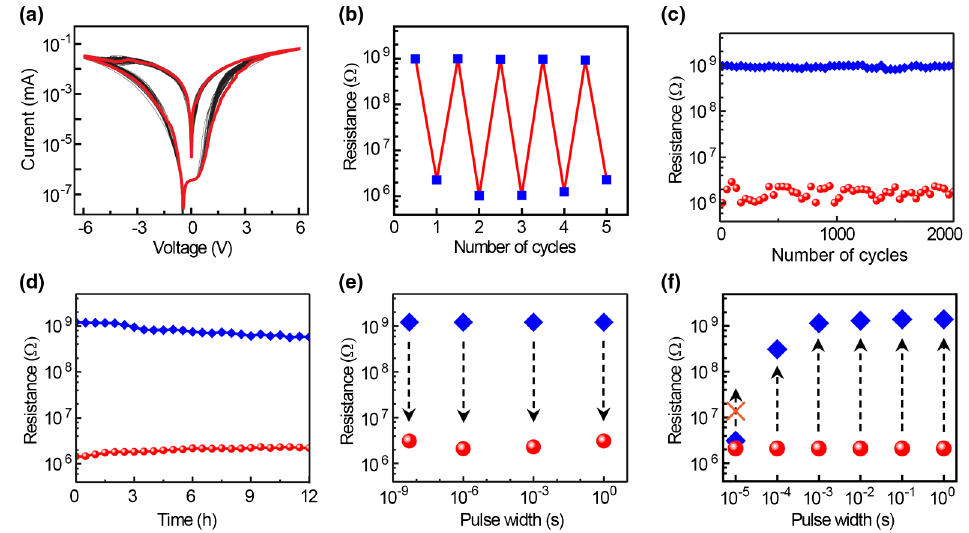
FIG. 10. Nonvolatile resistive switching of the LAO/STO memristors with LAO grown at a relatively high oxygen pressure of 10 (cid:2) 3 mbar . (a) After the initial forming sweep, bipolar resistance switching is very stable during the 100 successive voltage sweeps. The red curve represents the 100th cycle. (b) The HRS and LRS can be reversibly and reproducibly obtained by applying voltage pulses of (cid:5) 6 V . The readout voltage is 0.2 V. (c) Good endurance and no performance degradation are observed after 2000 cycles of write and erase operations. (d) Both the HRS and LRS are nonvolatile with a retention of more than 12 h. (e) Write speed can be as fast as 5 ns. (f) Erase operation takes more than 100 (cid:1) s . It is noteworthy that these characteristics are similar to the devices made at a relatively low oxygen pressure of 10 (cid:2) 6 mbar